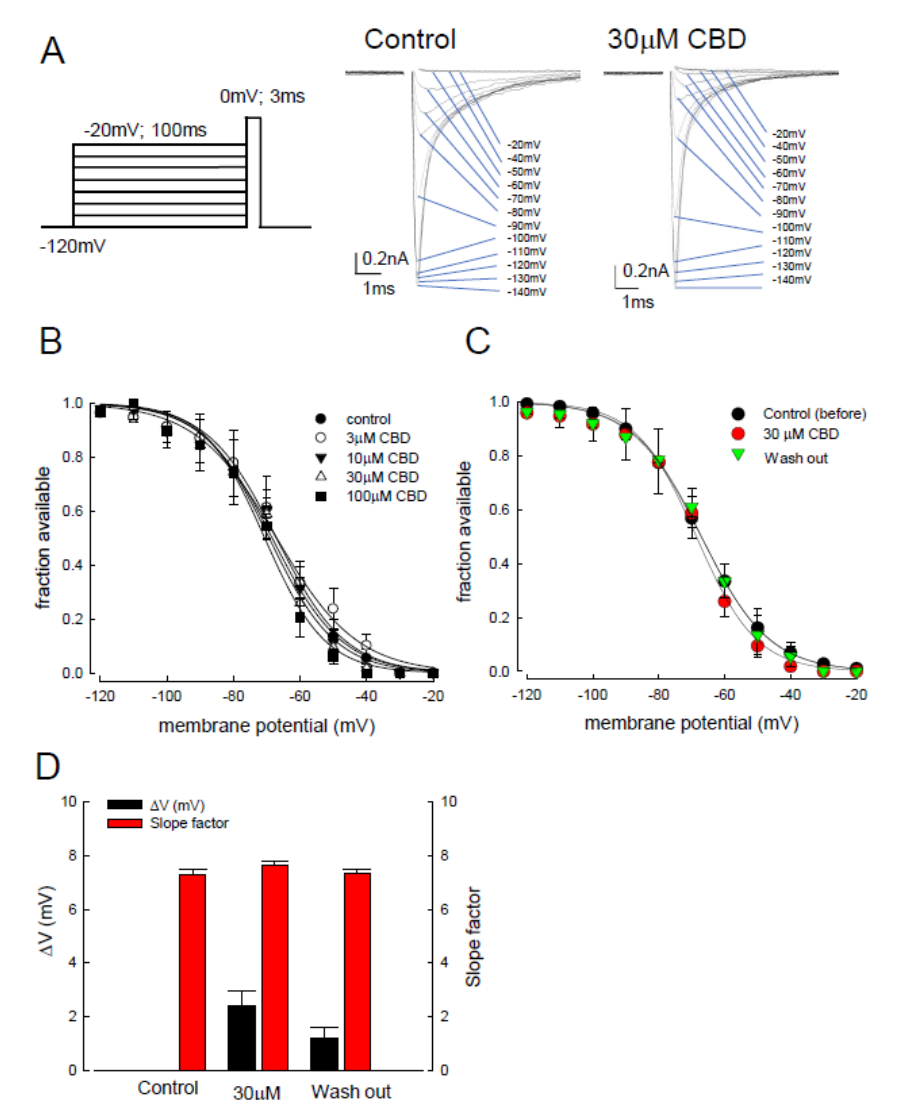
Figure 2. Cannabidiol induced changes in the fast inactivation curve of Na v 1.4 channel. ( A ) In our electric protocol to test the fast inactivation of Na v 1.4 channels, the cell was held at − 120 mV and then stepped to the depolarizing pulse up to − 20 mV (in 10 mV steps) for 100 ms, followed by a test pulse, 0 mV for 3 ms (left panel). The representative current sweeps of the Na v 1.4 channel was recorded after the short test pulse (right panel). ( B ) The inactivation curve shifted by CBD from the cells expressing Na v 1.4 channel is shown. Fraction available, defined as the normalized peak current (to the peak current with an inactivating pulse at − 120 mV), is plotted against the voltage of the inactivating pulse, between − 120 and − 20 mV, to show the inactivating curve. The inactivating curve did not shift significantly under treatment with different CBD concentrations (3, 10, 30, or 100 µ M CBD). ( C ) The inactivation curves of the control, CBD treatment, and washing out channels demonstrate no significant voltage shift during the approximately 100 ms depolarizing pulse. Lines are best fit using the Boltzmann function 1/(1 + exp[(V − V h )]/k), where V h were − 67.1, − 71.7, and − 67.4 mV, and k values were − 10.4, − 9.8, and − 10.7 for control, those cells after treatment of 30 µ M CBD, and those with washing out, respectively. ( D ) The shifts in inactivation curves ( ∆ V h ) in Figure 2C were 1.8 and 1.5 mV for those cells with 30 µ M of CBD and those after washing out, respectively. The k values were 7.3 ± 0.1, 7.6 ± 0.2, and 7.3 ± 0.2 for control, those cells with 30 µ M of CBD, and those post washing out of CBD, respectively (n =